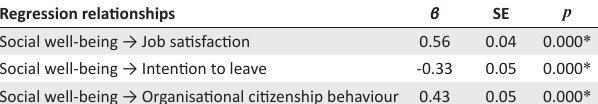
TABLE 3: Regression coefficients. Regression relationships